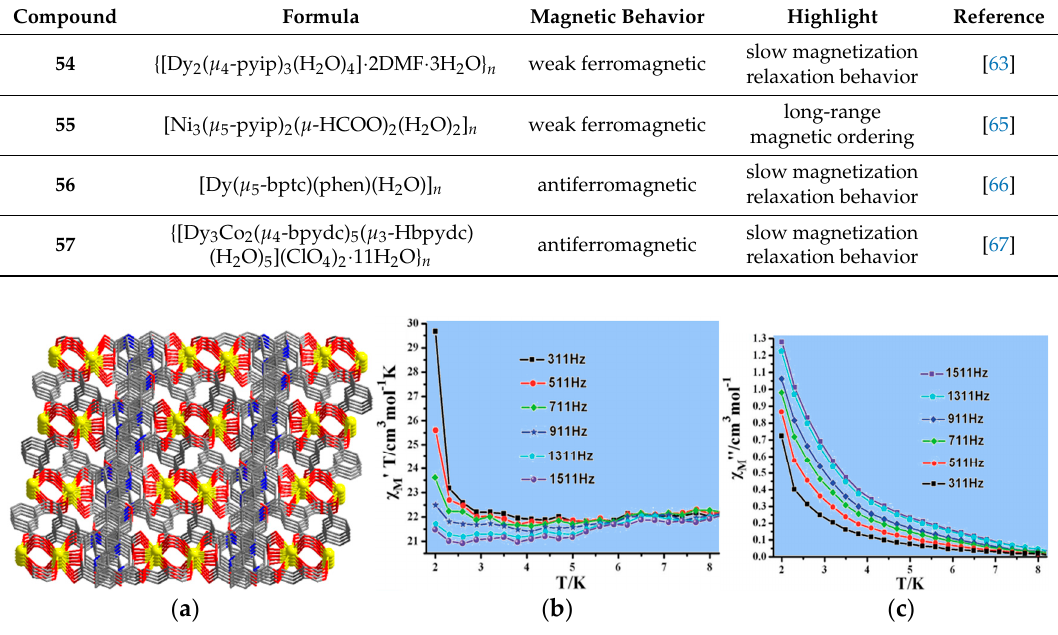
Table 10. Selected examples of CPs with unusual magnetic properties.